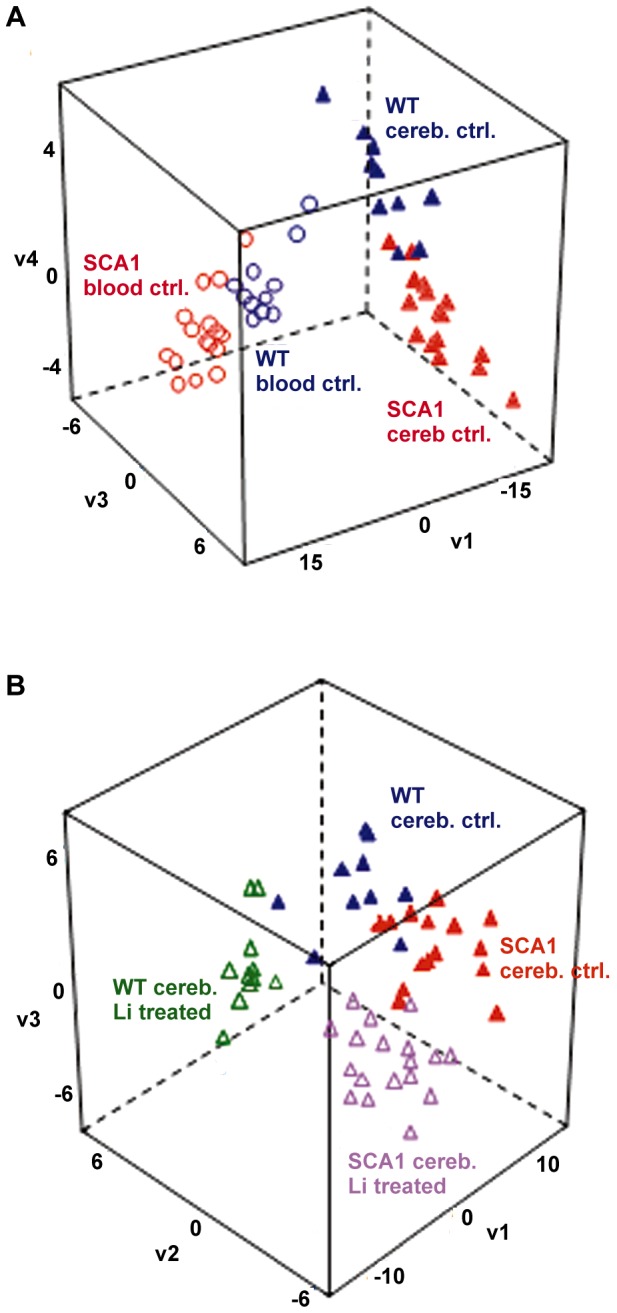
Supervised multivariate Partial Least Square separation of metabolic phenotypes.
A. Differences between plasma and cerebellum (vector v1) and between SCA1 and wild-type under control conditions (separated by vectors v3 and v4). B. Differences between Lithium treated and control conditions in cerebellum (vector v1) and between SCA1 and wild-type (separated by vectors v2 and v3). Abbreviations: Cereb, Cerebellum; Ctrl, Control; Li, Lithium; WT, Wild-type.